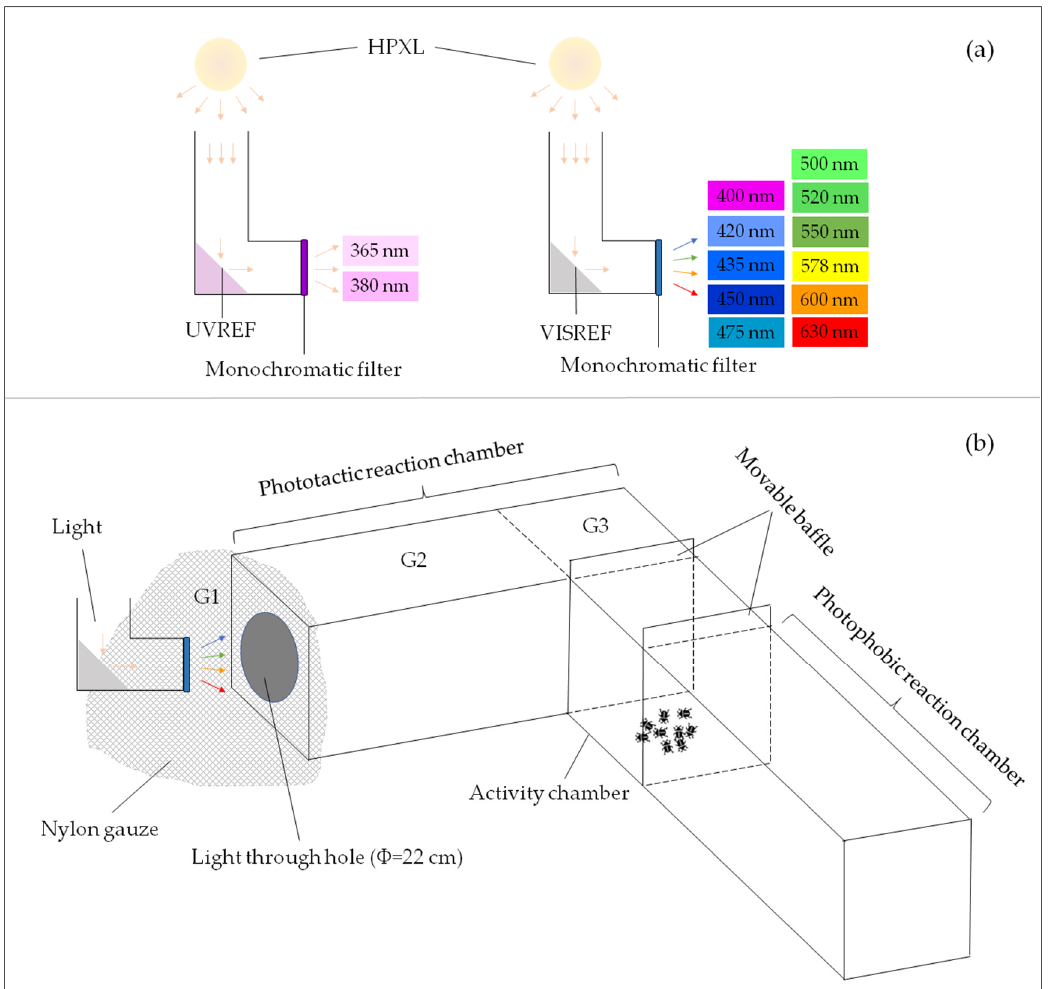
Figure 1. Optical path system and response device of phototactic behavior of Exolontha castanea adults. ( a ) Optical path system; ( b ) Response device of phototactic behavior. G1 indicates the strong phototaxis of adults (i.e., the adults fly toward the light source and out of the device through the hole), G2 indicates the medium phototaxis of adults (i.e., the adults fly toward the light source but stop halfway), and G3 indicates the weak phototaxis of adults (i.e., the adults climb to the light area but do not fly toward the light source).